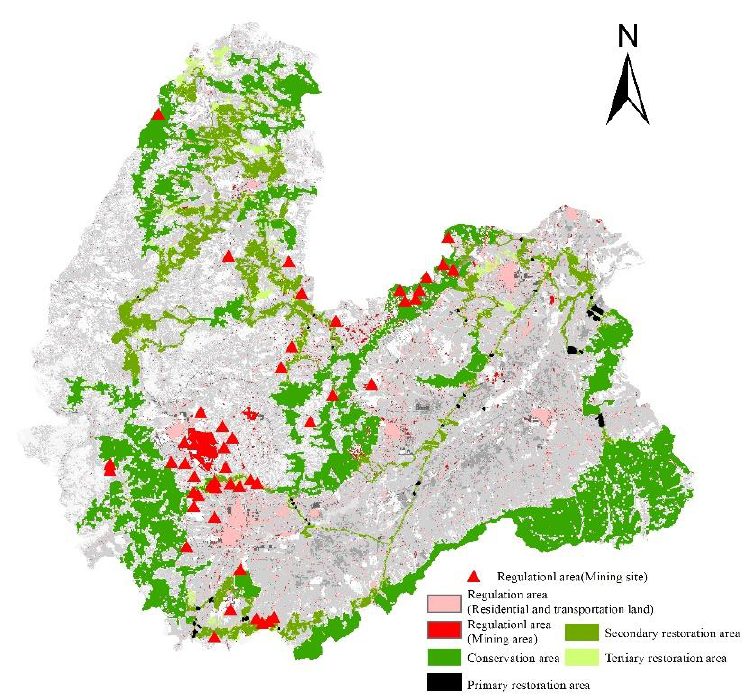
Figure 9. Ecological protection and restoration zoning. Table 3. Proportion of land-use type area in tertiary ecological restoration zones in 2010 and 2017.